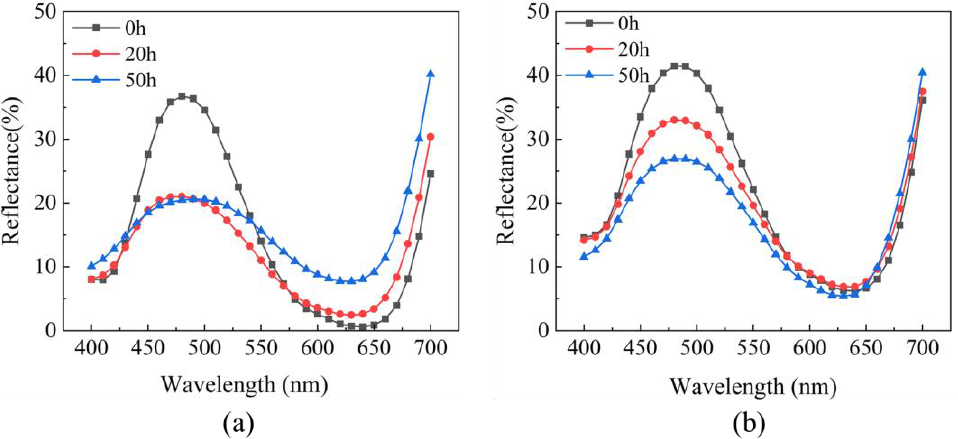
Figure 7. ( a ) Reflectance spectra of untreated dyed wood and ( b ) treated dyed wood irradiated at 0, 20, and 50 h. 20, and 50